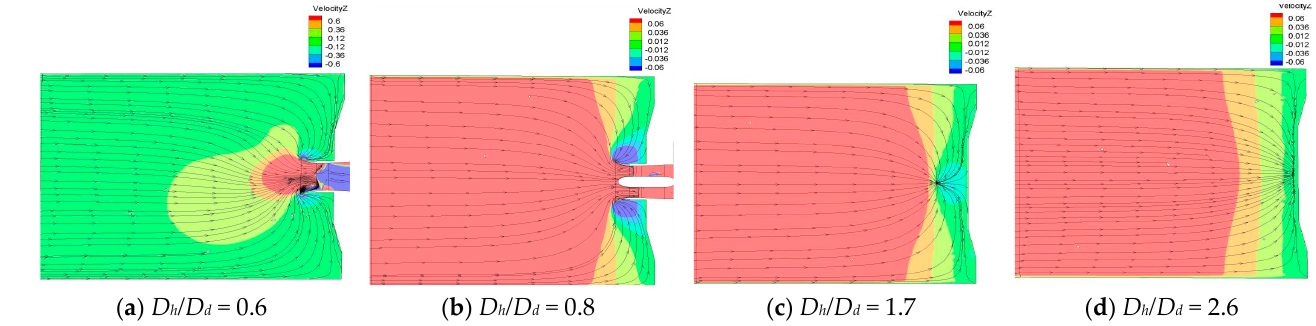
Figure 11. Suction sump flow line and axial flow velocity distribution (section 2 - 2, unit: m/s).